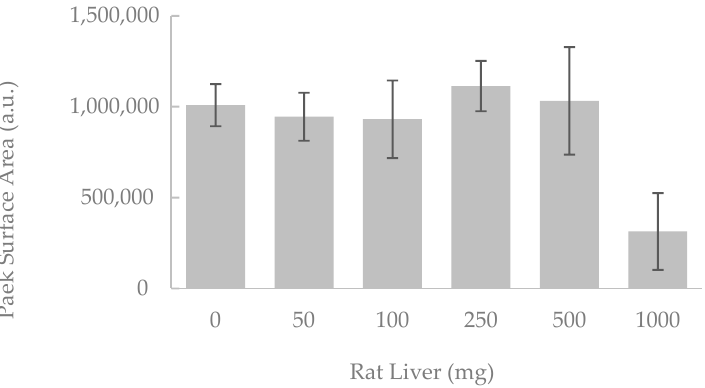
Figure 2. Chromatographic peak surface area (mean ± standard deviation) from an addition of 10 µL of AuNP suspension (2.7 nmol Au 3+ added) in crucibles containing different rat liver masses ( N = 3).